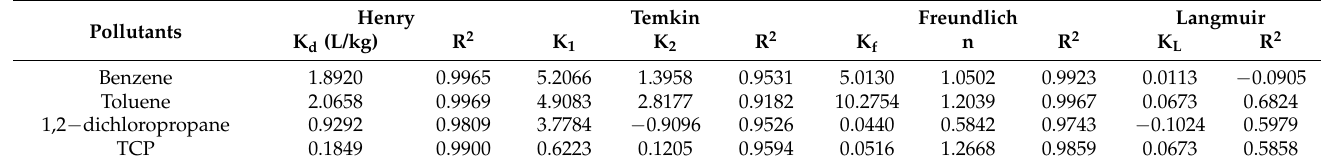
Figure 2. Isotherm fitting curves for each pollutant (The initial concentration of individual benzene, toluene, 1,2 − dichloropropane and TCP was 1, 2, 4, 6, 8, and 10 mg/L, respectively. A total of 5 g of sand was added to 25 mL of pollutant solution). ( a ) Henry model; ( b ) Temkin model; ( c ) Freundlich model; ( d ) Langmuir model. Table 2. Fitting parameters of isothermal adsorption models.